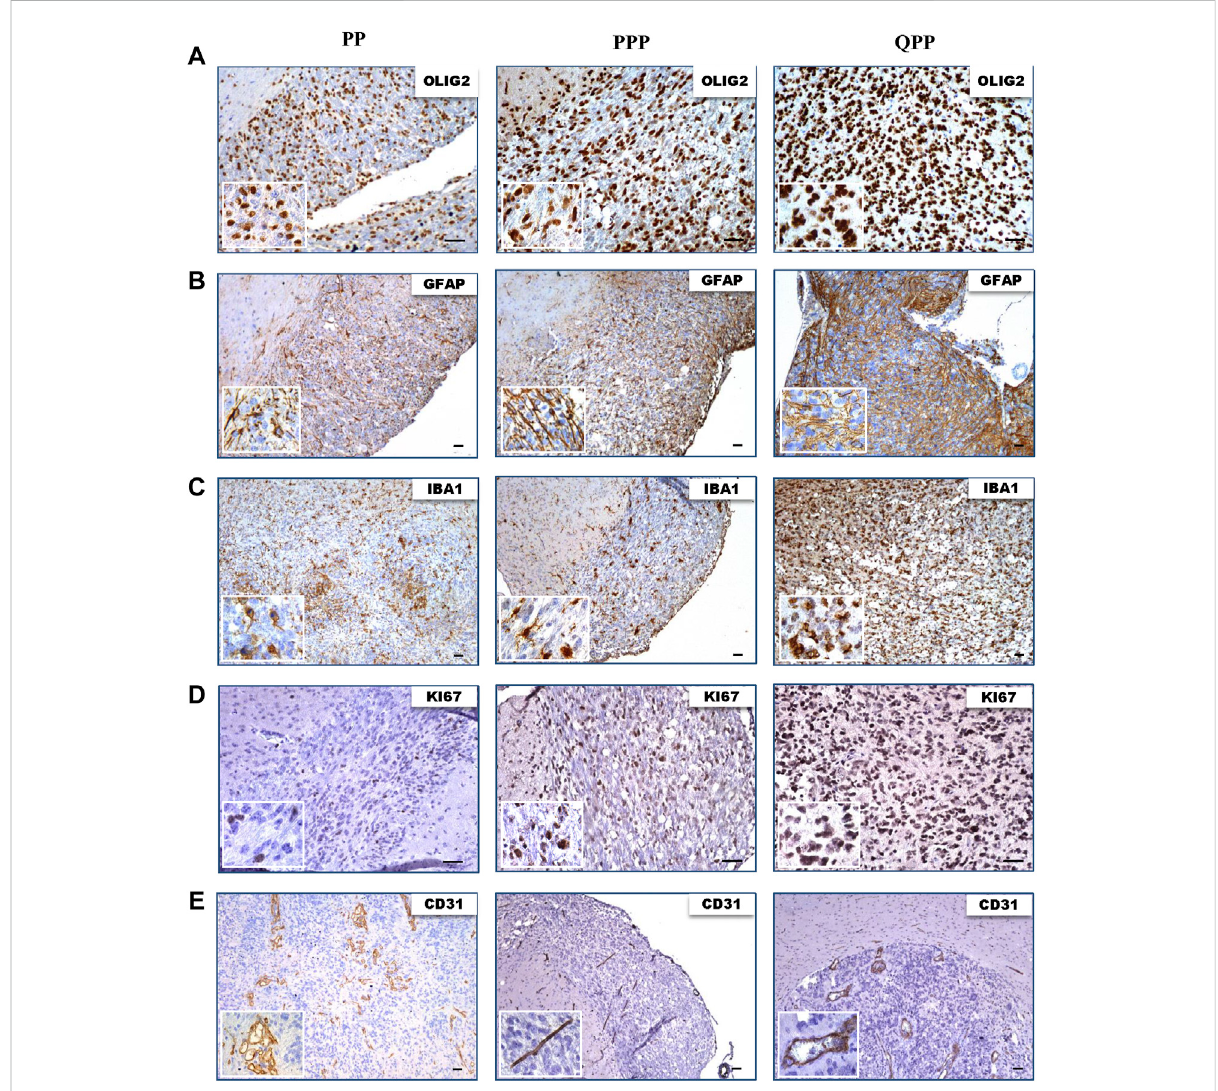
FIGURE 4 Tumors harvested fromall three models expresselevatedlevels ofglioma biomarkers. (A) .IHC images oftumorsharvestedfrom QPP,PPP, and PP cohorts demonstrating OLIG2 expression. (B) . IHC images of tumors harvested from QPP, PPP, and PP cohorts demonstrating GFAP expression. (C) .IHCimagesoftumorsharvested fromQPP,PPP,and PPcohortsdemonstratingIBA1expression. (D) .IHCimages oftumorsharvested fromQPP, PPP, and PP cohorts demonstrating KI67 expression. (E) . IHC images of tumors harvested from QPP, PPP, and PP cohorts demonstrating CD31 expression. Scale bars represent 50 μ